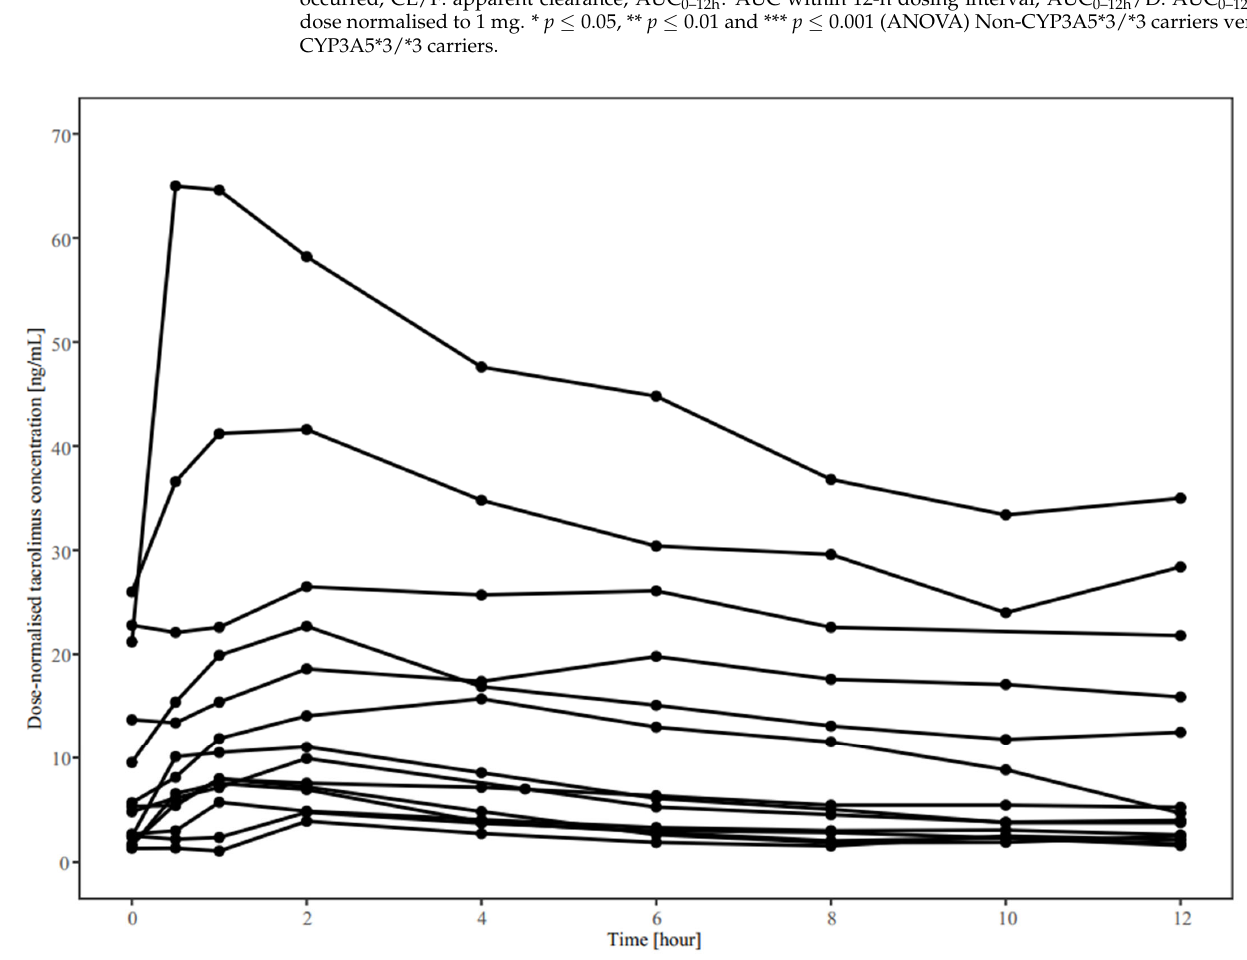
Figure 1. Dose-normalised concentration–time profiles of tacrolimus in 14 adult lung transplant pa- tients.